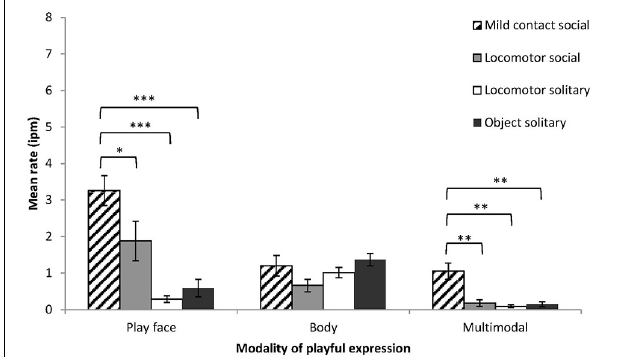
FIGURE 3 | Mean rates (intervals per minute of play, with SE) of chimpanzee infants’ playful multimodal expressions during social and solitary play contexts. PF, play face. ∗ p < 0 . 05, ∗∗ p < 0 . 01.